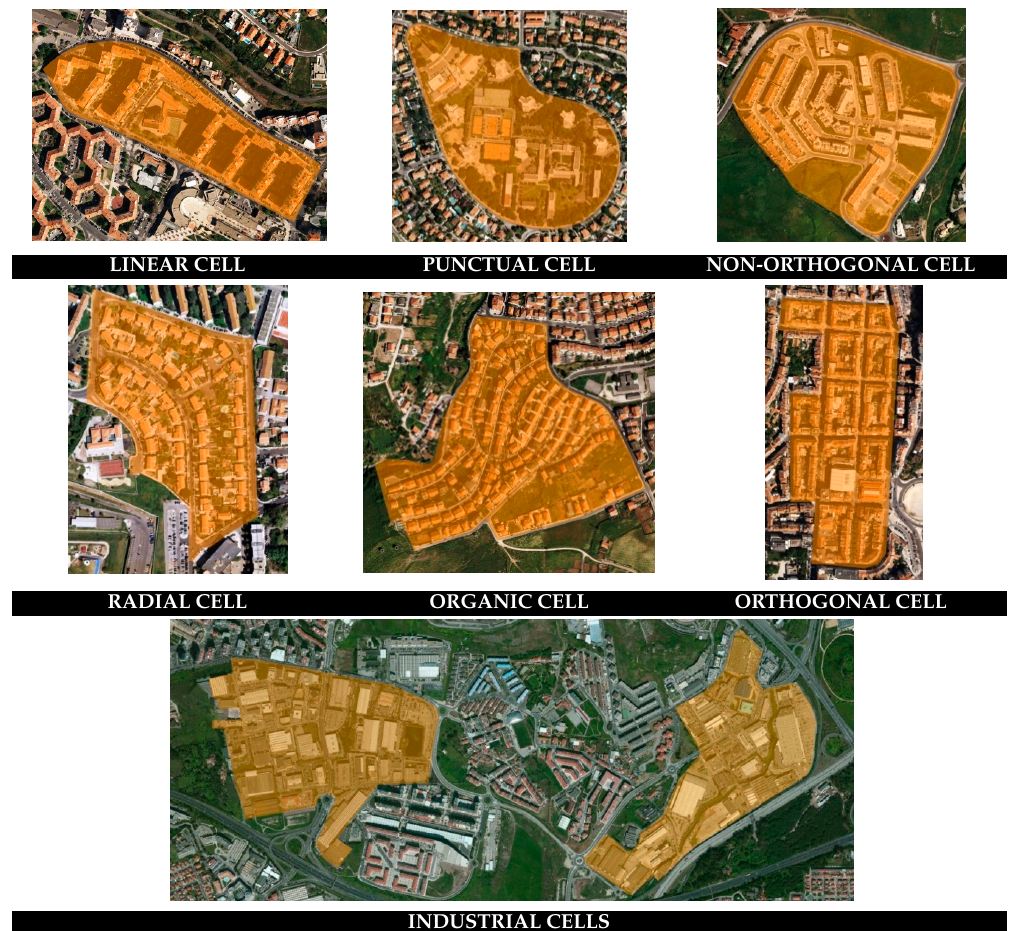
Table 1. Examples of urban units based on statistical subsection delimitation across the city.